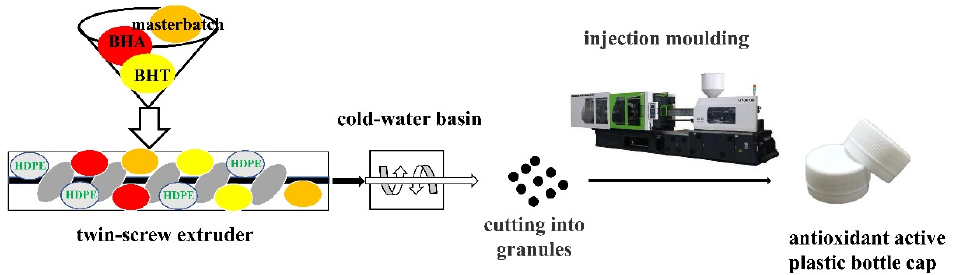
Figure 1. Schematic flow of the extrusion process used in the production of antioxidant active plastic bottle caps.